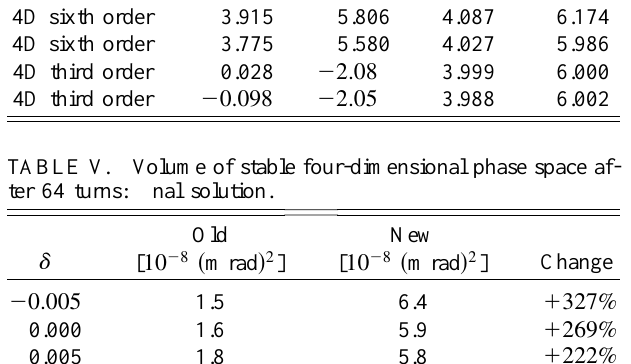
TABLE II. Volume of stable four-dimensional phase space af- ter 64 turns: first solution. Old